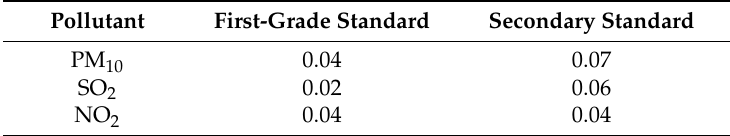
Table 2. The table of air quality classification standards (unit mg/m 3